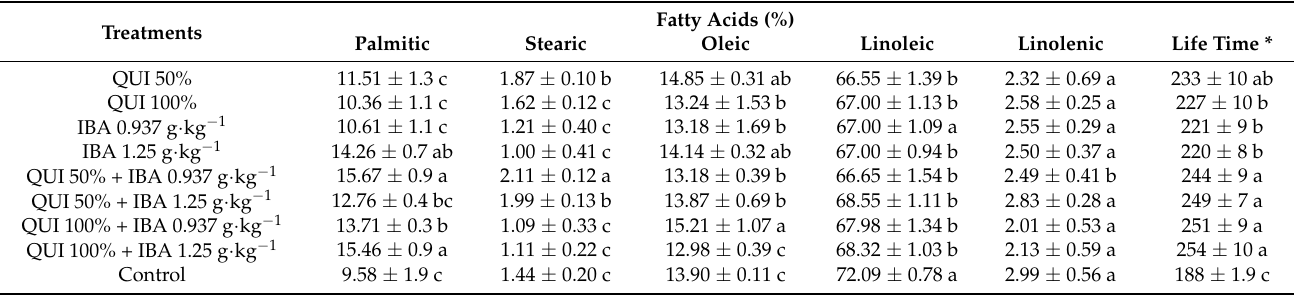
Table 7. Effect of the application of Chitosan (QUI) and Indole Butyric Acid (IBA) on the profile of fatty acids (palmitic, stearic, oleic, linoleic and linolenic) in the seed of S. bigelovii plants and life cycle (in days) under conditions of the Altar desert,